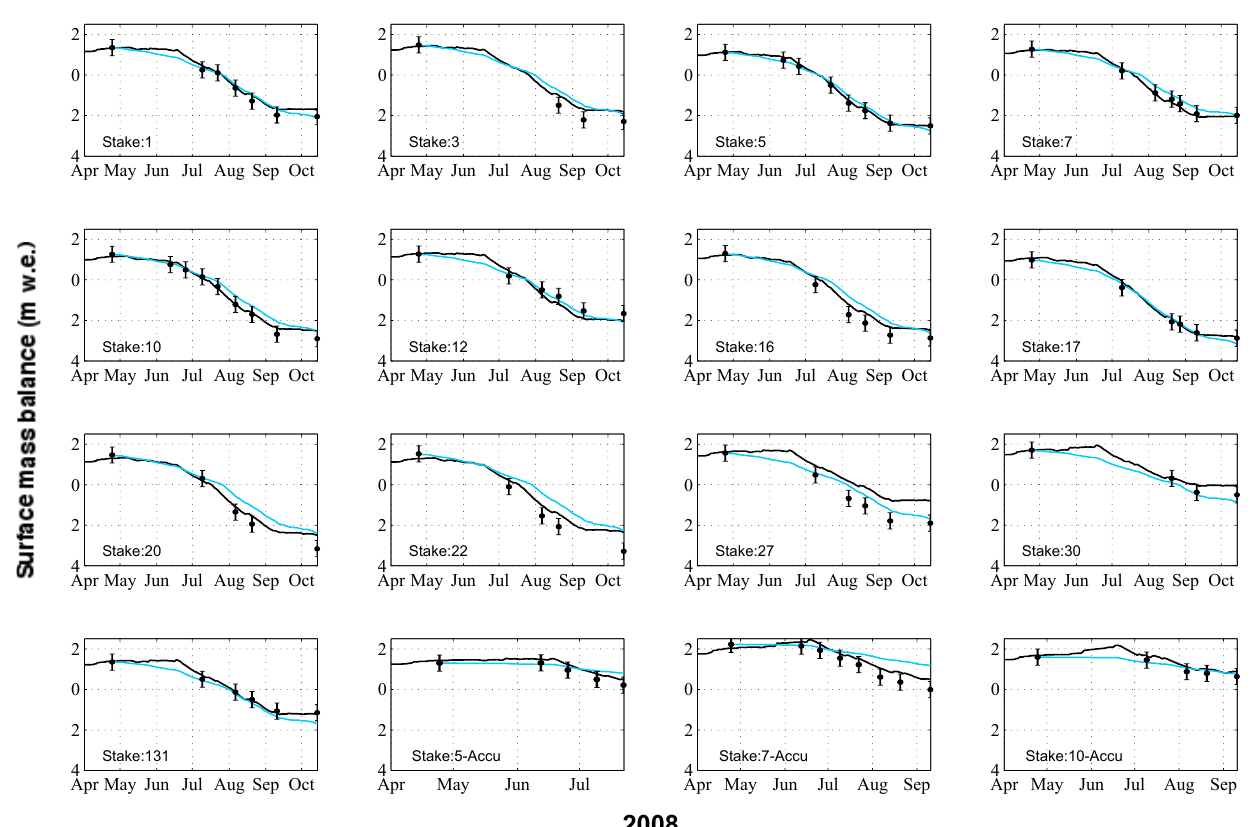
Figure 5. Surface mass balance evolution at some selected measurement points of Saint-Sorlin Glacier over the hydrological year 2007– 2008. Black lines represent the simulated SMB using Crocus model with corrected forcing. The blue curves show the simulation made with the ATI model using simulated winter SMB adjusted with measurements. Black dots represent the measurements with their uncertainties.